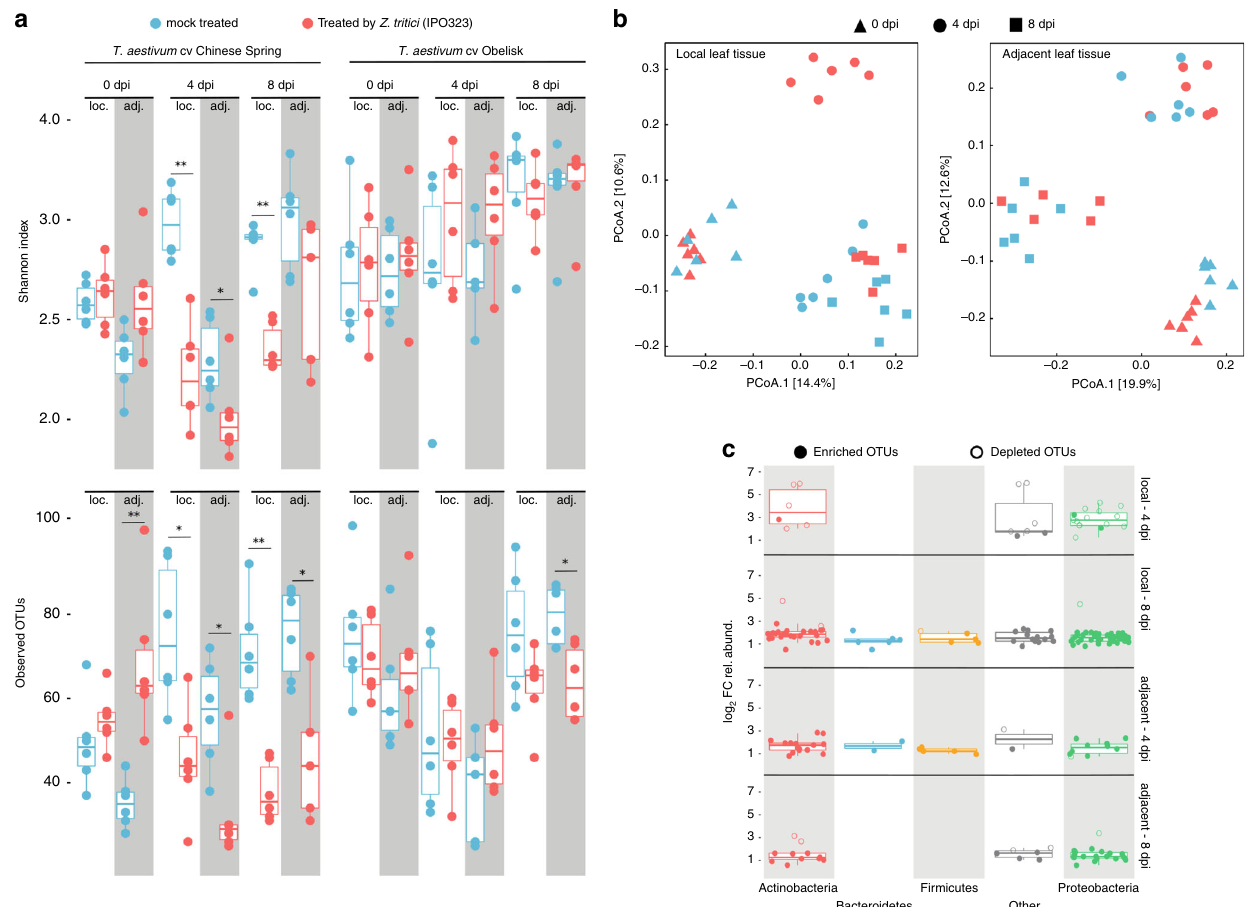
Fig. 5 Infection by Z. tritici alters the wheat microbiota in local and adjacent leaf tissues. a Two measures of the community composition, Shannon index and observed OTUs, are depicted in upper and lower panels, respectively. Reads were rare fi ed to an even sequencing depth corresponding to the smallest simple size of 601 reads. Community composition in leaf samples treated by Z. tritici (red boxplots) were compared to mock treatment (blue boxplots) for each corresponding time point (i.e., 0, 4, and 8 dpi-f) and leaf tissue types, local (loc.) and adjacent (adj.). Infection by Z. tritici leads to a signi fi cant drop in the computed Shannon indexes and observed OTUs in both types of leaf tissues (local and adjacent). Testing for signi fi cance was performed using a Kruskal – Wallis rank sum test. * P < 0.05; ** P < 0.01; *** P < 0.001. b Principal coordinates analysis (PCoA) computed on Bray-Curtis distances of microbial communities associated with T. aestivum cultivar Chinese Spring. Each shape in the plot represents the community structure of one sample. Red- and blue- colored shapes designate mock- and Z. tritici -treated leaf samples as in ( a ). PCoA plots in the left and right panels correspond to local (left) and adjacent (right) leaf tissues, respectively. c Boxplot depicting log 2 fold changes in the relative abundance of OTUs. Colors in the graph depict bacterial phyla. OTUs with P > 0.05 were fi ltered out. Filled and un fi lled circles indicate OTUs that are signi fi cantly enriched and depleted, respectively, from Z. tritici -treated leaf samples compared to mock-treated samples. Number of biologically independent replicates: n =